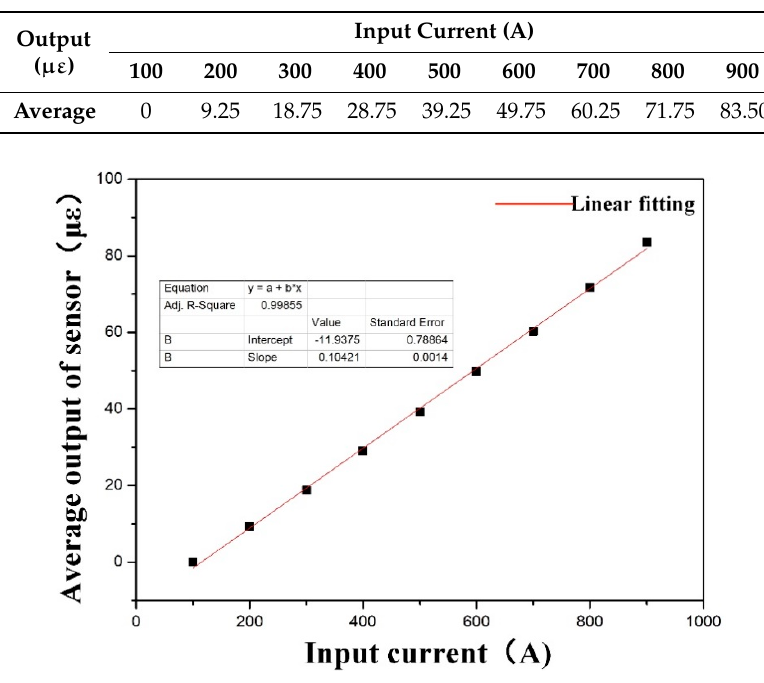
Figure 12. Sensitivity test of sensor.